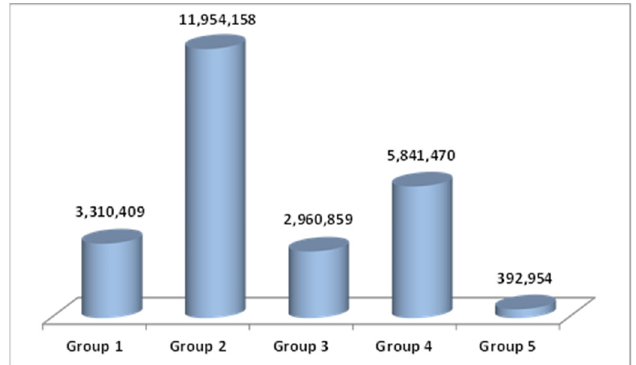
Figure 3. Population of each group of cities. Table 2. Statistical data by population and household of each group of cities.